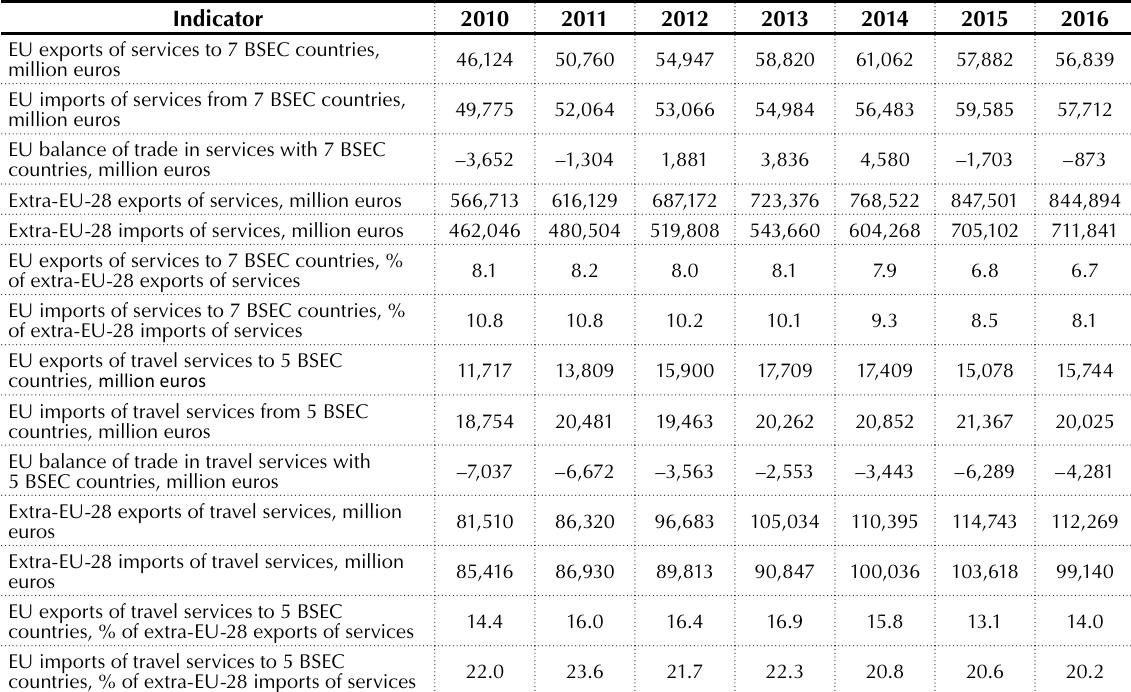
Table 5. Trends in the EU trade in services and travel services with the BSEC countries, million euros